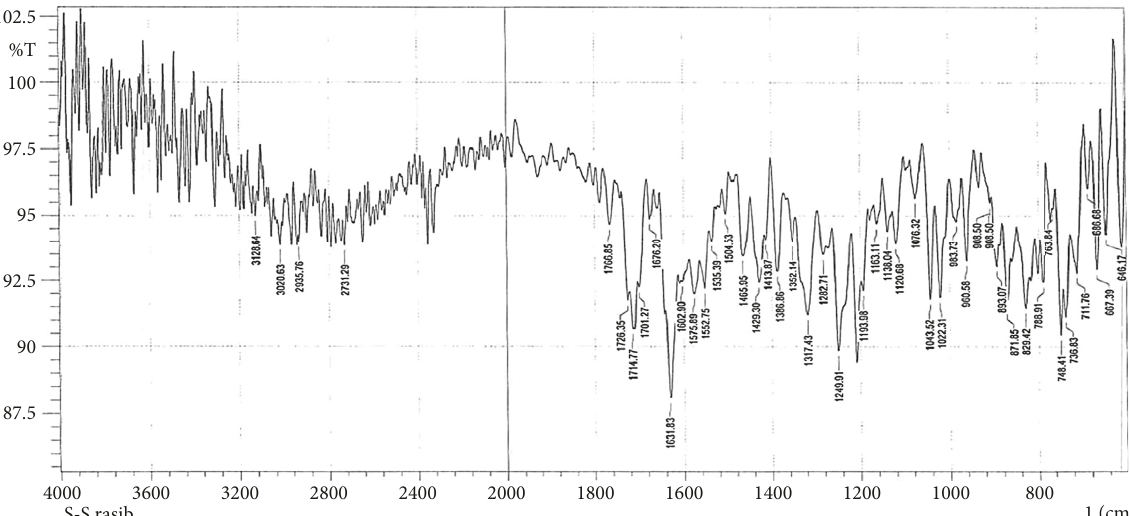
Figure 4: Fourier Transform Infrared Spectrum of